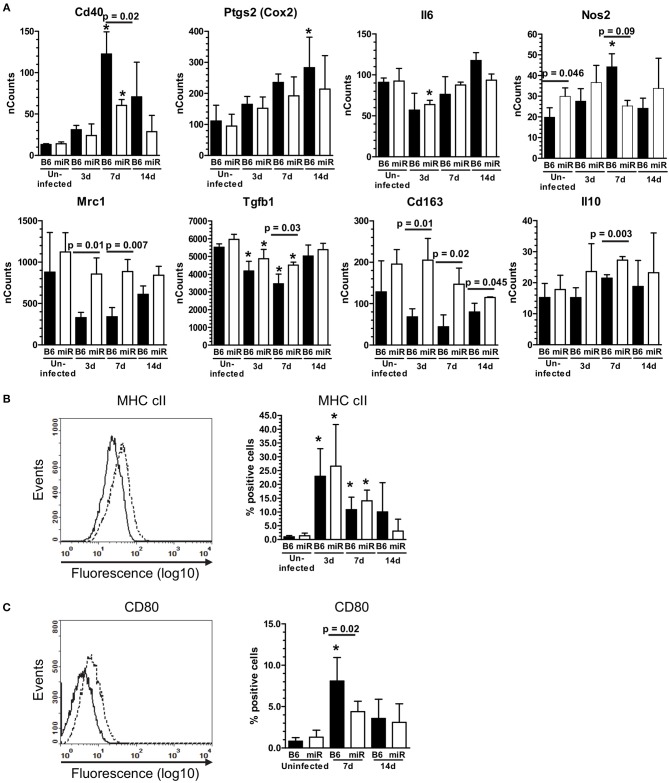
L. monocytogenes infection induces M1-polarization in microglia from C56BL/6 mice, but not B6.miR-155−/− mice. (A) mRNA expression in microglia from L. monocytogenes EGD-infected male and female B6.WT () and B6.miR-155−/− () mice shown in Figure 5A was analyzed by nCounter. mRNA expression is presented as the mean ± SD nCounts from 3 pools of sorted microglia per genotype. (B,C) Brain cells from uninfected B6.WT and B6.miR-155−/− mice and from mice infected with 3.3–4.2 × 105 CFU L. monocytogenes EGD were incubated with the indicated mAb or isotype control mAb and analyzed by FACS. Microglia were gated as shown in Figure 4. Left panels show isotype (solid line) and test (dotted line) histograms from representative mice. Results from 3 experiments were combined and are presented are the mean + SD % marker positive microglia from B6.WT () and B6.miR-155−/− () mice expressing MHC cII (B) or CD80 (C) at the indicated time (n = 4–17 mice/genotype). *p < 0.05 compared with uninfected mice of the same genotype by 1-way ANOVA with Dunnett's post-test. Significant p-values between genotypes calculated by 2-tailed Student's t-test are given.